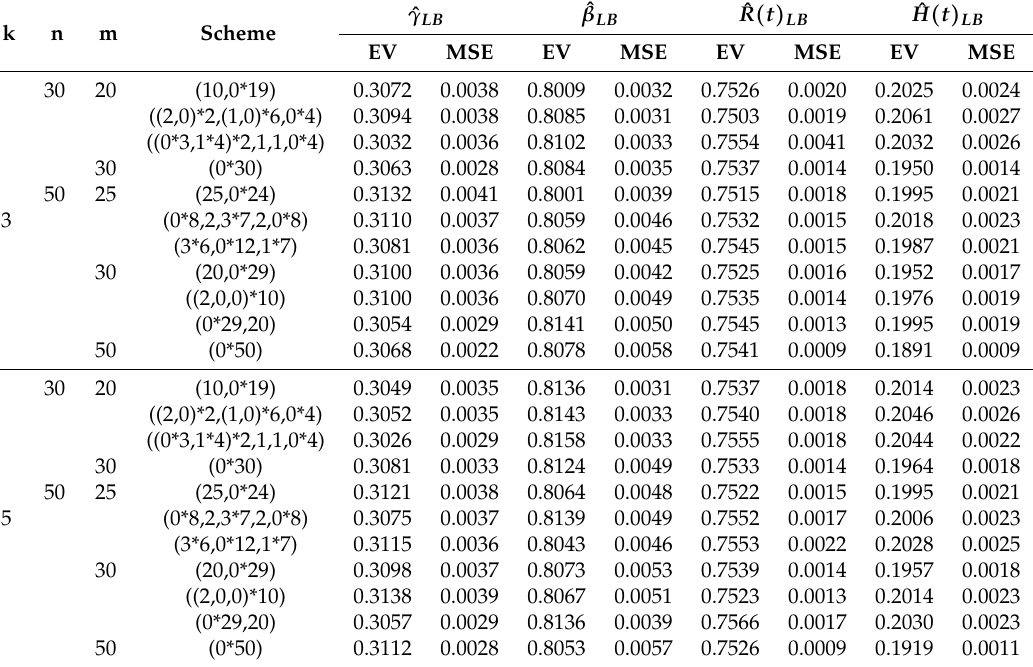
Table 7. Lindley approximation values and MSEs of parameters and reliability and hazard functions under LLF when h = 1, γ = 0.3, β = 0.8, t = 1.5, a 1 = 1.08, b 1 = 3.6, a 2 = 16, b 2 = 20, R ( t ) =